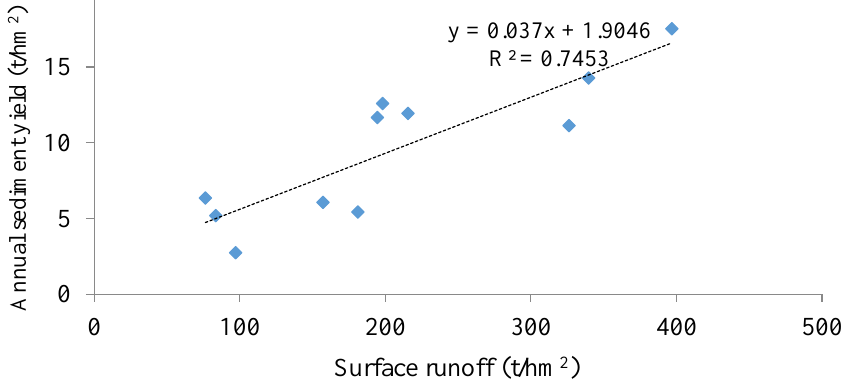
Figure 13. Relationship between annual surface runoff and annual sediment yield.